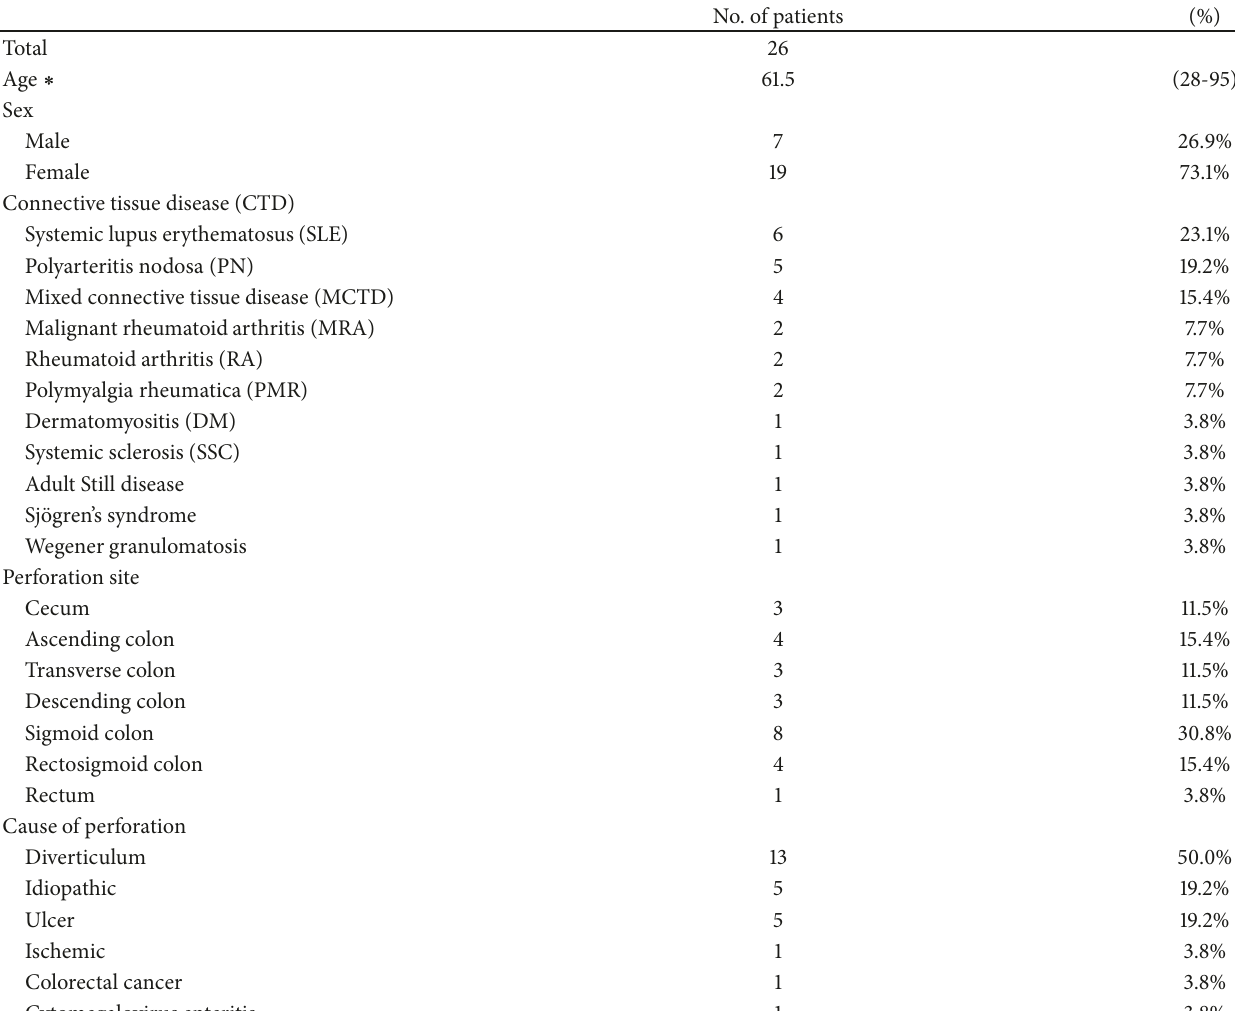
Table 3: The Characteristics of the patient with